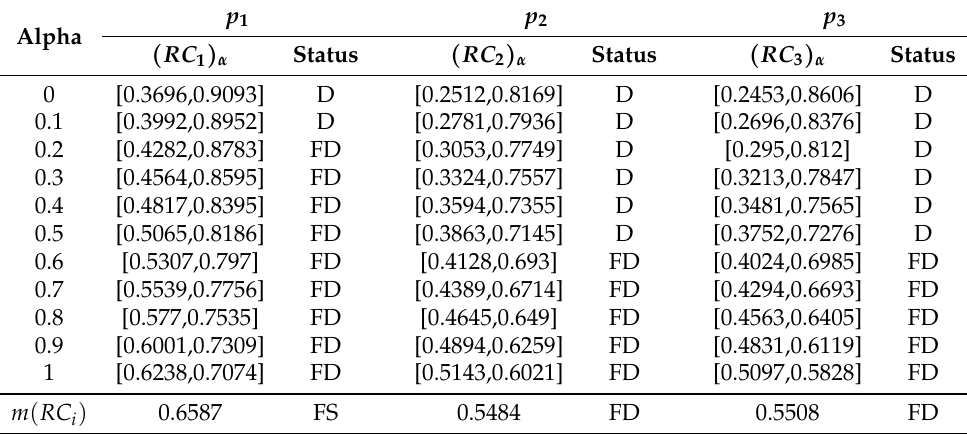
Table 14. Sensitivity analysis results of RC i and related status